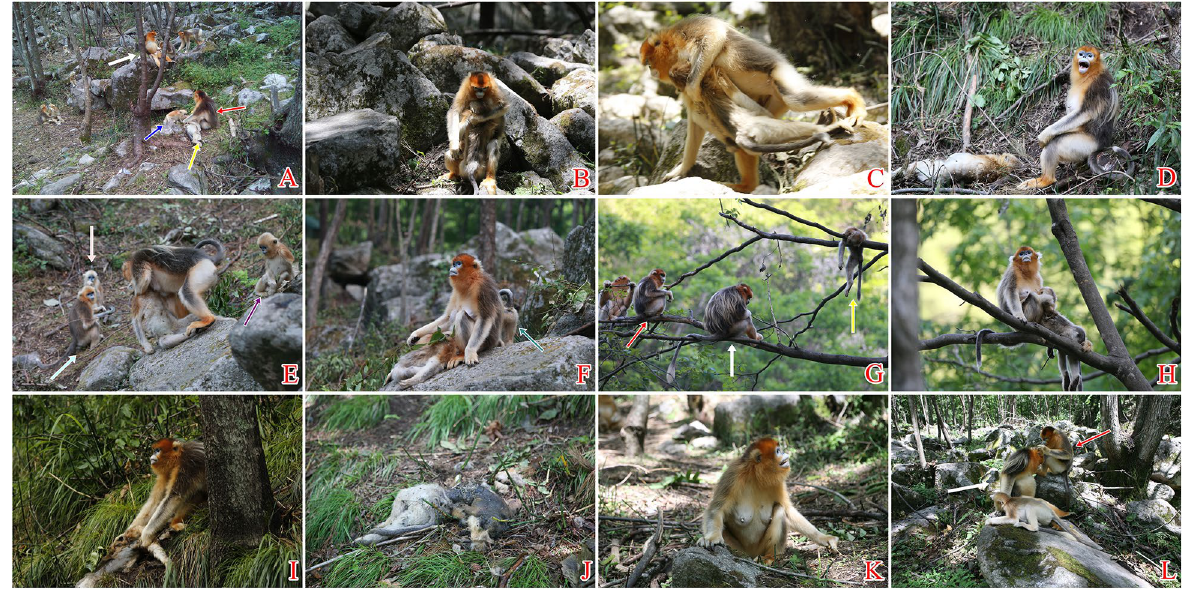
Figure 1. Responses of group members in Rhinopithecus roxellana . ( A ) The mother (red arrow) holds the dead juvenile (yellow arrow), and juvenile J3 (blue arrow) touches it. The OMU adult male (white arrow) remains nearby in a tree. ( B ) The mother holds the head of the corpse against her chest. ( C ) The mother struggles to walk with the corpse. ( D ) The mother, sitting alone beside the dead juvenile, emits calls. ( E ) The mother carries the corpse as she moves towards her OMU. ( F ) After the mother laid some leaves on the corpse a juvenile (teal arrow) approached, looked and left. ( G ) The mother (red arrow) draped the corpse (yellow arrow) over a branch, and moved to sit near the adult male (white arrow). ( H ) The mother put the head of the dead juvenile against her left breast, as if breastfeeding. ( I ) The mother had difficulty carrying the now-clearly decomposing corpse. ( J ) The decomposing body of the dead juvenile. ( K ) The mother looks toward where she abandoned the corpse and emits contact vocalizations. ( L ) The mother (red arrow) grooms the adult male (white